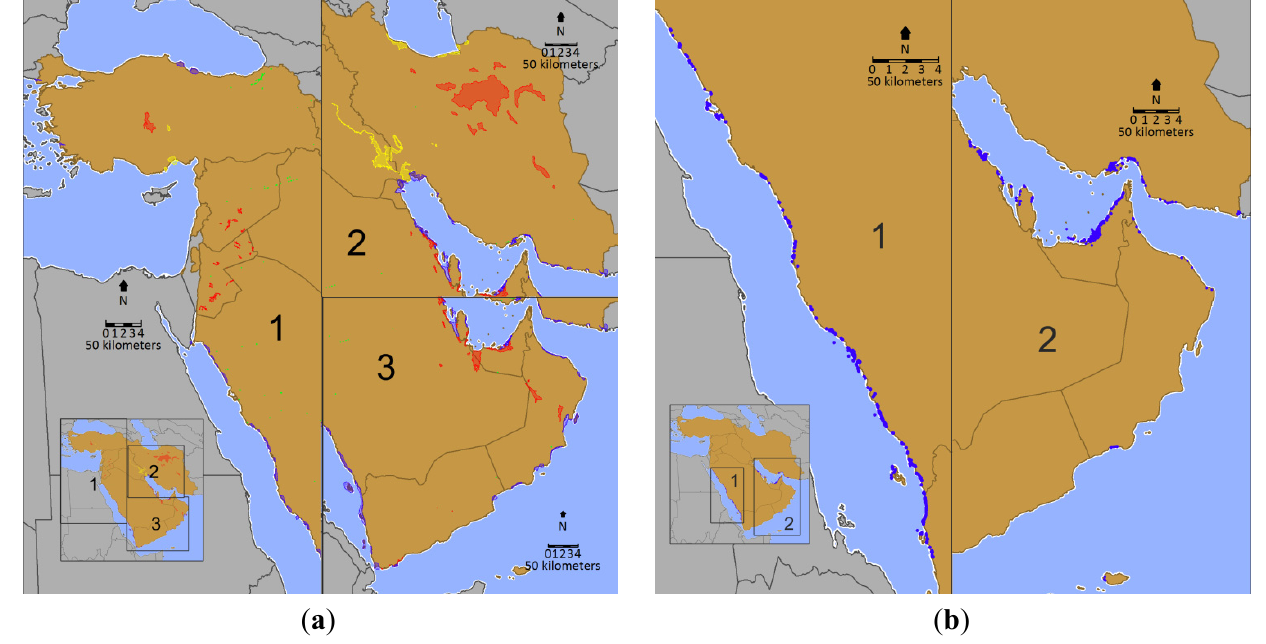
Figure 3. Maps of wetland distributions in West Asia. Study nations are colored brown, non-study nations are grey and water bodies are light blue. ( a ) Wetland distribution in 2000. Different wetland classes are indicated by color: Yellow for freshwater marsh and floodplain; dark blue for coastal wetland including estuary, delta, and lagoon but excluding mangrove; red for pan, brackish/saline wetland; and green (visually exaggerated for illustration purposes) for bog, fen, and mire; ( b ) Mangrove distribution in 2010, indicated by dark blue. Mangrove areas have been visually exaggerated for illustration